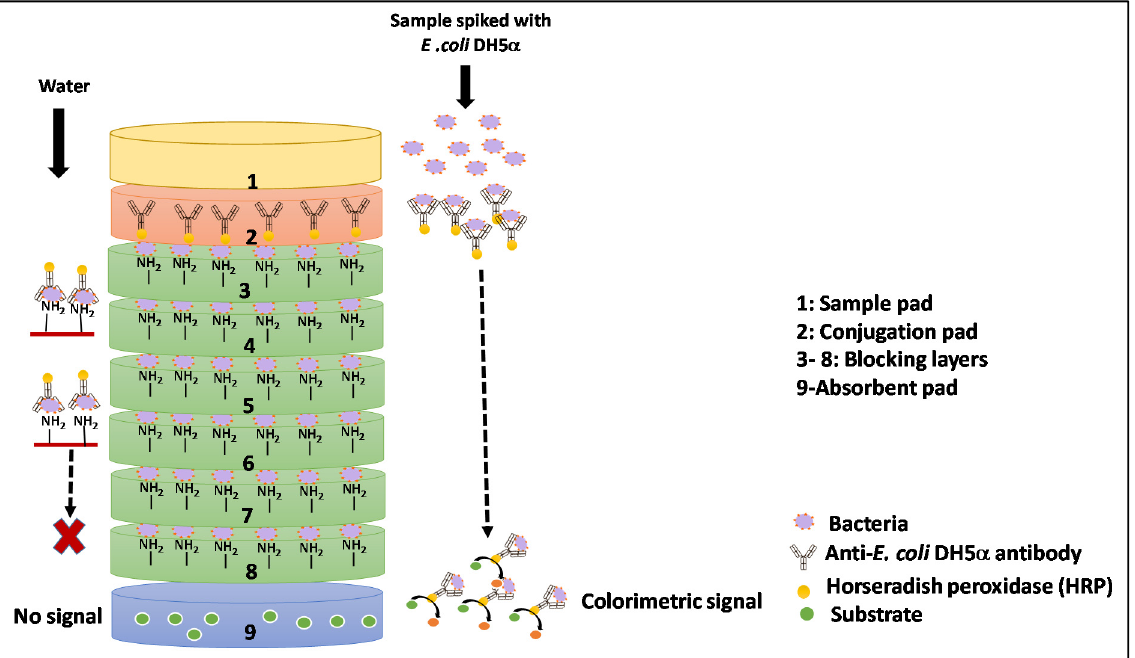
Figure 1. Schematic description of the vertical flow immunoassay and the assessment process. As the spiked sample is added to the sample pad, the bacteria bind to antibodies on the conjugate pad and form antibody-bacterial complexes that eventually migrate through the pads to the bottom-placed absorbent pad, thereby generating a positive colorimetric signal. In negative control without bacteria (water), free antibodies get released from the conjugation pad along with sample medium and bind to the immobilized E. coli cells on the blocking layers and thus do not proceed to the absorbent pad, producing no signal.